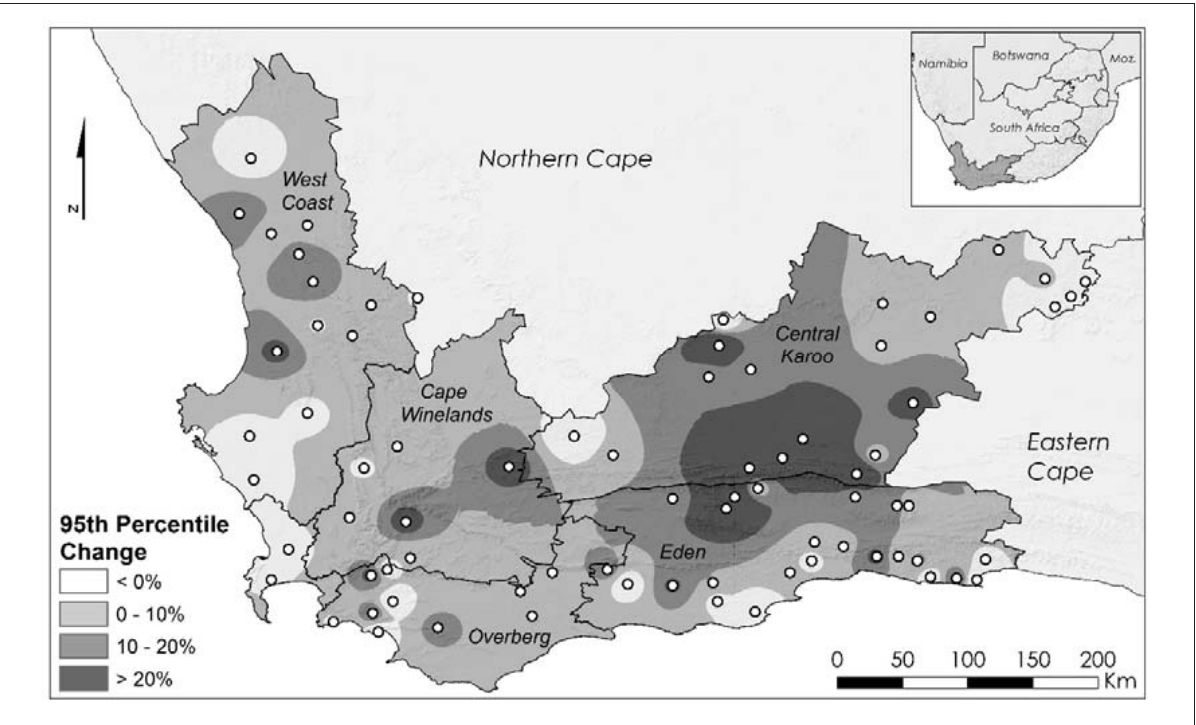
Figure 7: Spatial changes in 95th percentile between 1950–1979 and 1980–2009 periods in the Western Cape Province interpolated between rainfall stations using inverse-distance weighting